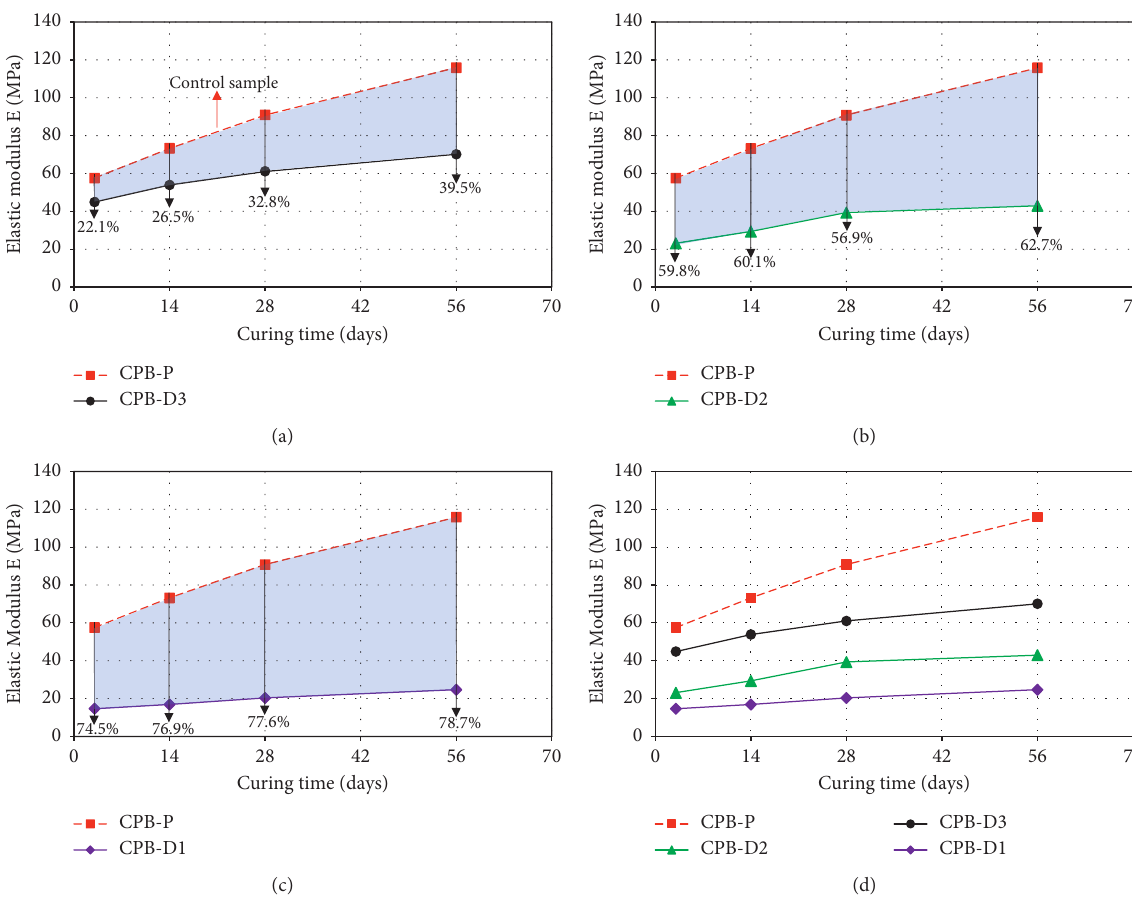
Figure 5: Change in elastic modulus with time for diverse mine